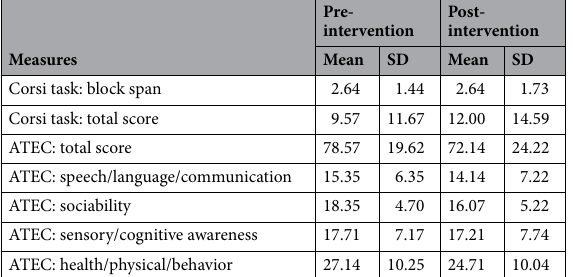
Table 2. Mean and standard deviation values of the outcome measures before and after the